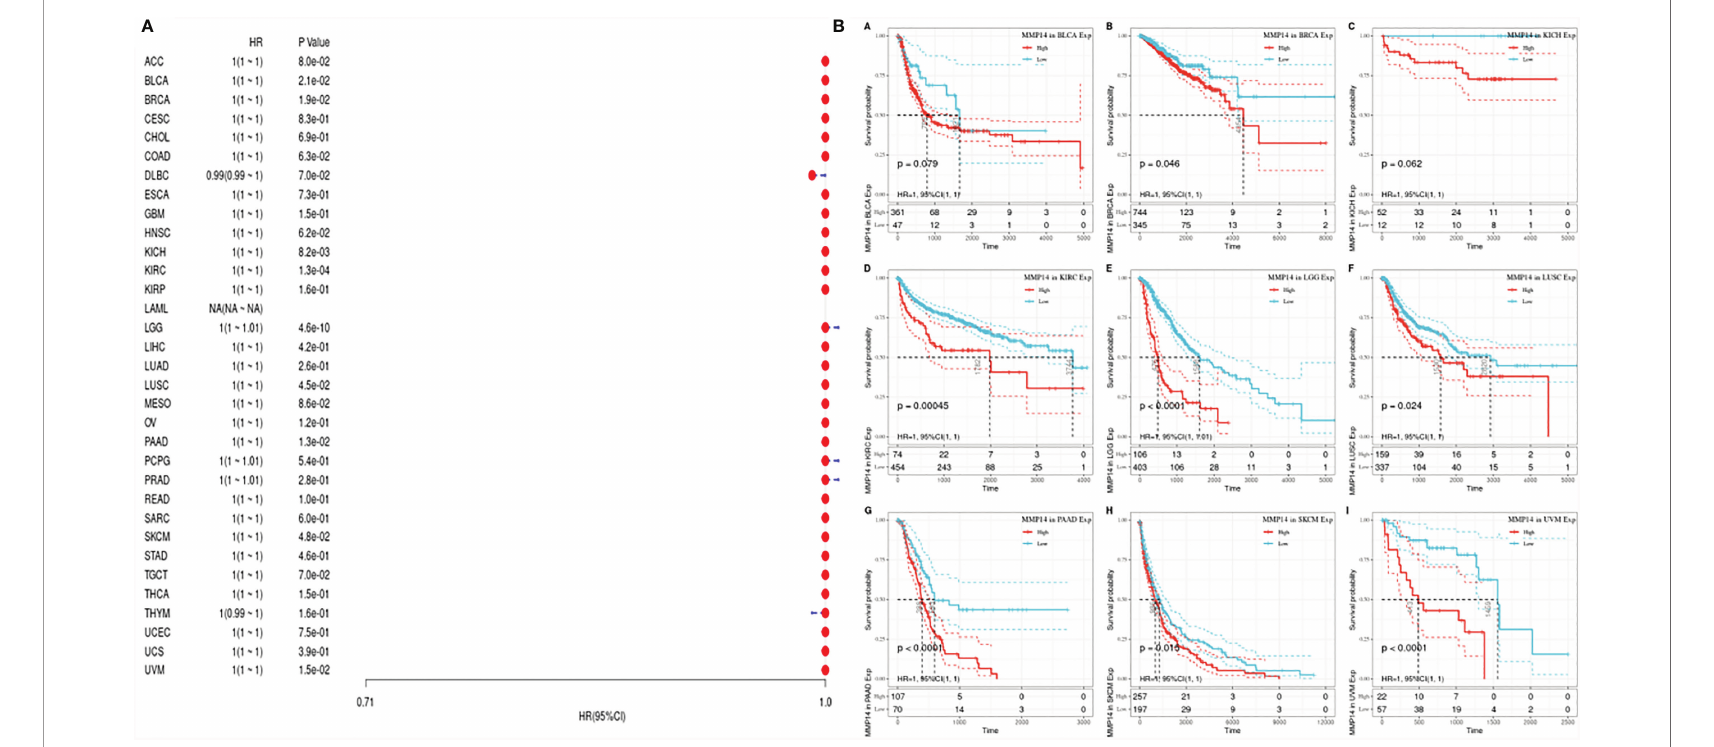
FIGURE 5 | The relationship between MMP14 expression and PFI prognosis was analyzed. The expression of MMP14 and prognosis of pan cancer disease-speci fi c survival were analyzed by PFI. The relationship between MMP14 expression and disease-free survival was analyzed by DSS. The expression of MMP14 and the overall survival rate of pan cancer patients were analyzed by PFI. (A) Correlation analysis of MMP14 expression and PFI in different cancer types of TCGA; the red part represents the risk ratio. Due to the limited sample size, the parameters and hazard ratio could not be calculated with short bars, and the red font indicates P < 0.05. (B) Kaplan – Meier analysis was used to generate a survival curve for the prognostic effect of MMP14 expression on pan cancer. PFI, progression-free interval